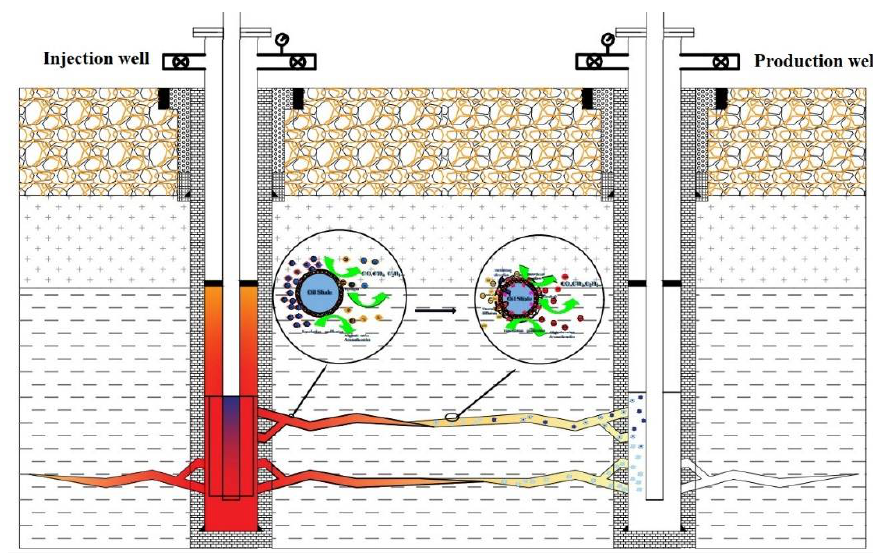
Figure 9. A schematic diagram of oil and gas migration from oil shale pyrolysis.